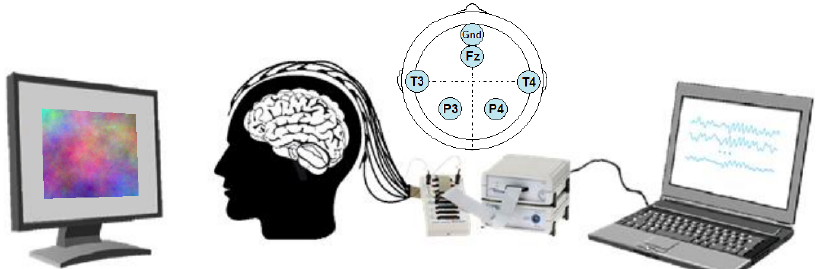
Figure 1. Experimental setup: Screen, participant with electroencephalography (EEG) headset, EEG hardware acquisition system and PC. The electrodes positioning schema is presented on